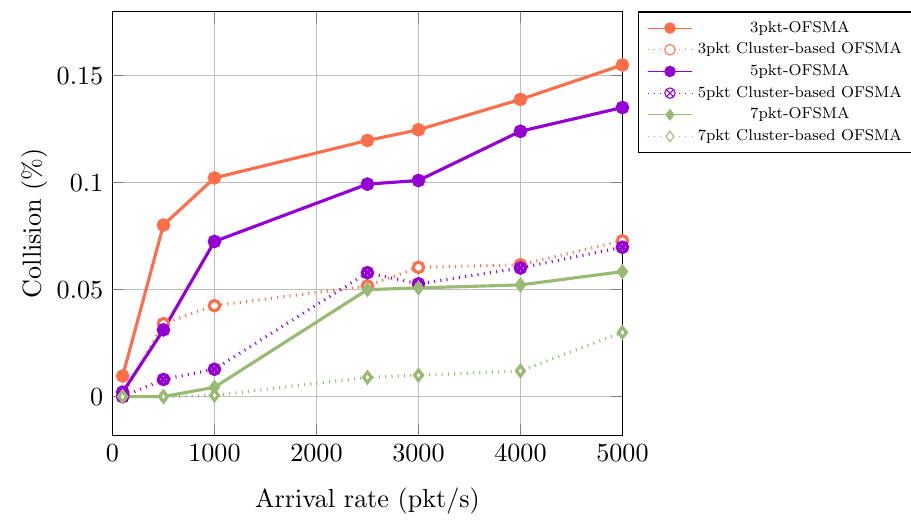
Figure 11. Collision percentages for different packet